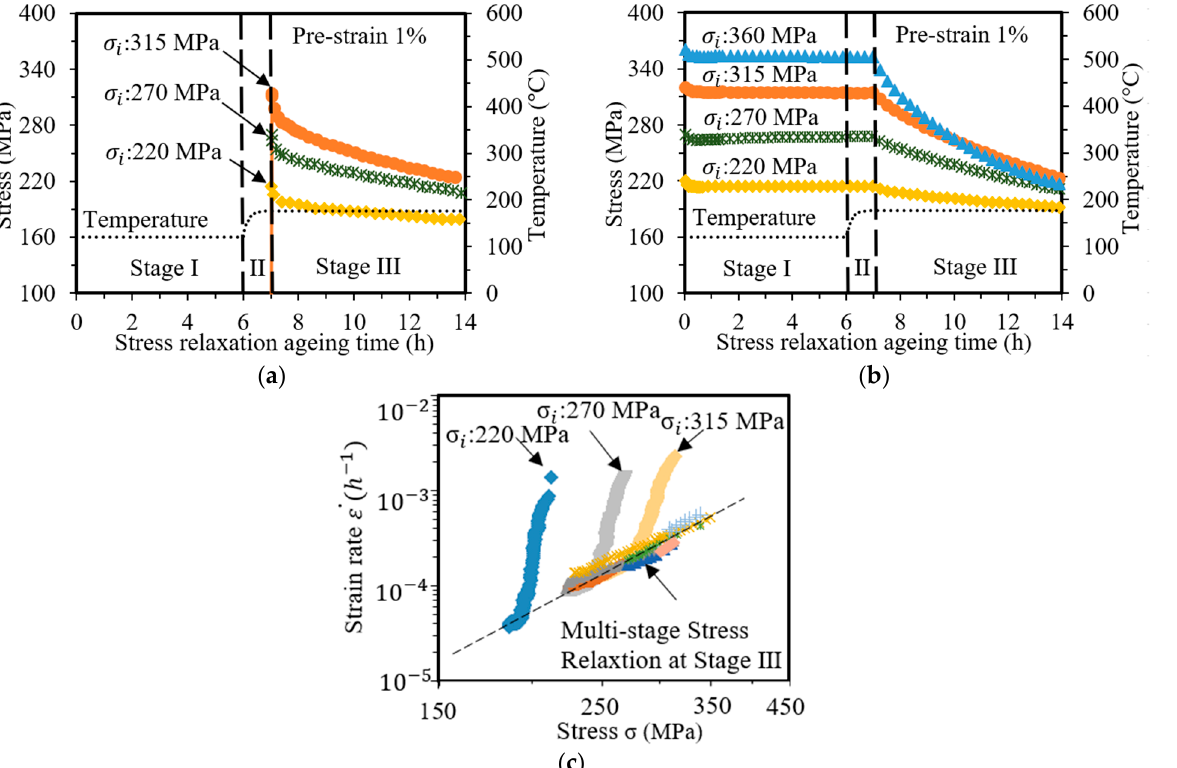
Figure 8. ( a ) Single-stage and ( b ) multi-stage stress relaxation curves of 7050 aluminum alloy with various stress levels during ageing at 177 °C. ( c ) The calculated strain rate vs. stress. The evolution of strain rate is calculated by the slope of single-stage stress relaxation curves in ( a ) and multi-stage stress relaxation curves in ( b ). Note that the multi-stage stress relaxation curves were reprint/adapted with permission from [40], Materials Science and Engineering A; published by Elsevier, 2018.